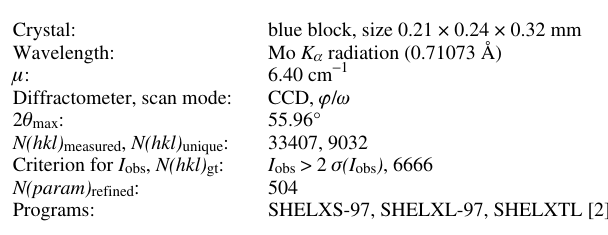
Table 1. Data collection and handling.